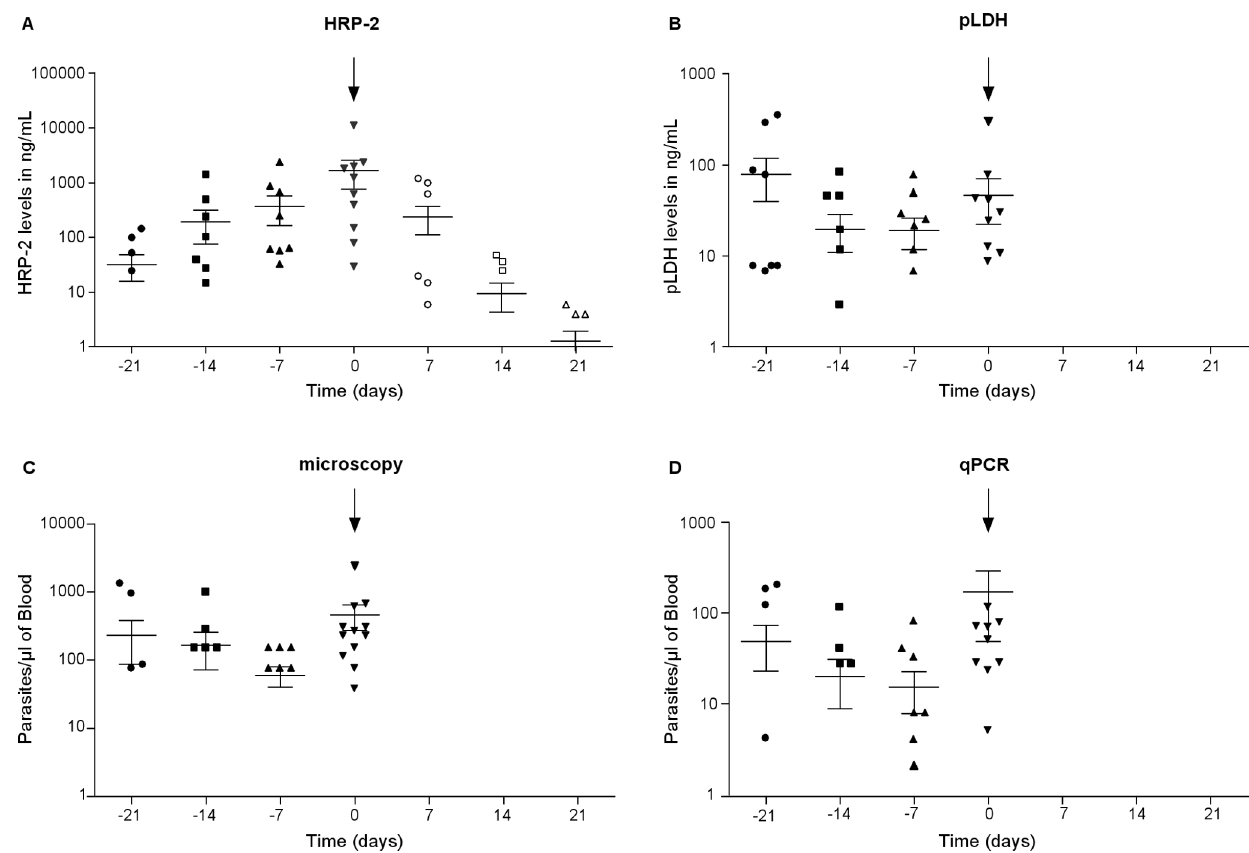
Figure 3. Utility of microscopy, qPCR, PfHRP-2 and pLDH ELISAs in predicting clinical episodes. Parasite dynamics before clinical malaria attack ( day 0 ) as measured by (A) Pf HRP-2, (B) p LDH (C) Microscopy and (D) qPCR, for the 12 participants with microscopically confirmed clinical malaria. Parasite dynamics after clinical attack are also presented for Pf HRP-2 (A). Error bars represent standard error of mean of the parasitemia values at each time point. The arrows indicate the day of treatment. Microscopy, p LDH and qPCR did not detect malaria parasites after the treatment.